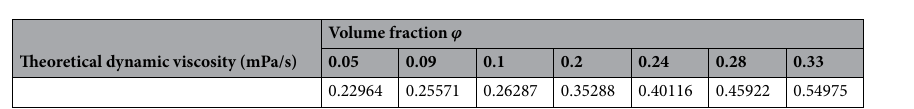
Table 8. Theoretical dynamic viscosity of the nanorefrigerant.